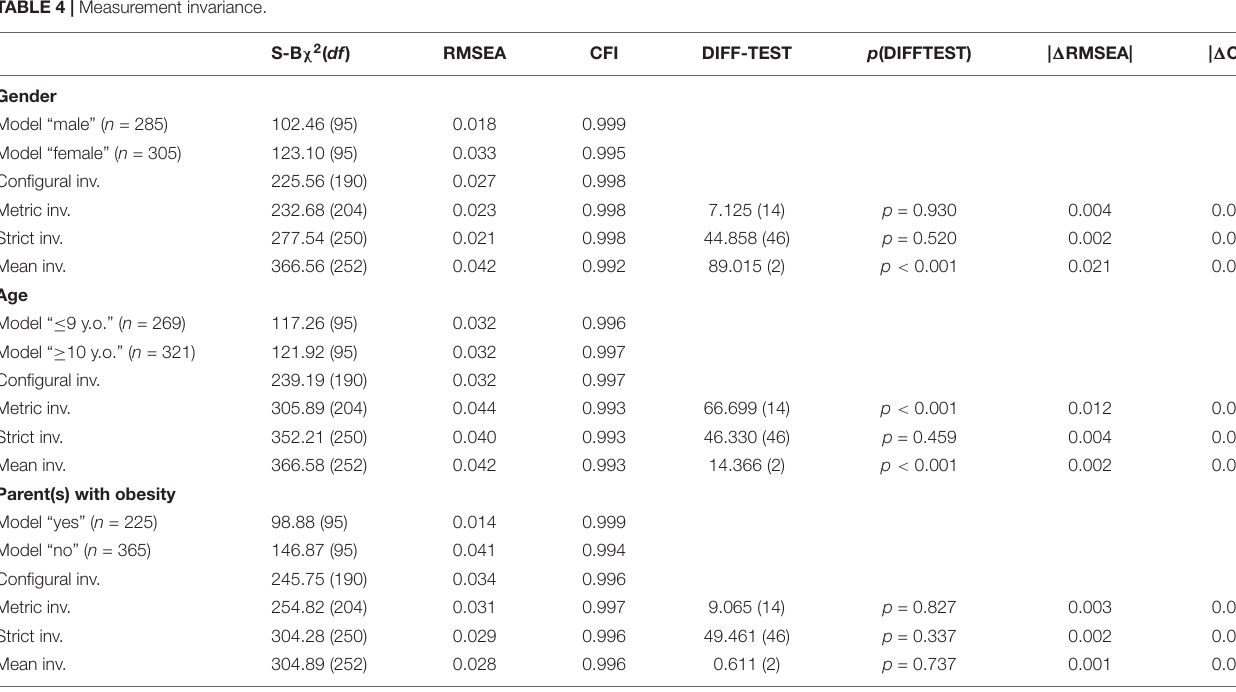
TABLE 4 | Measurement